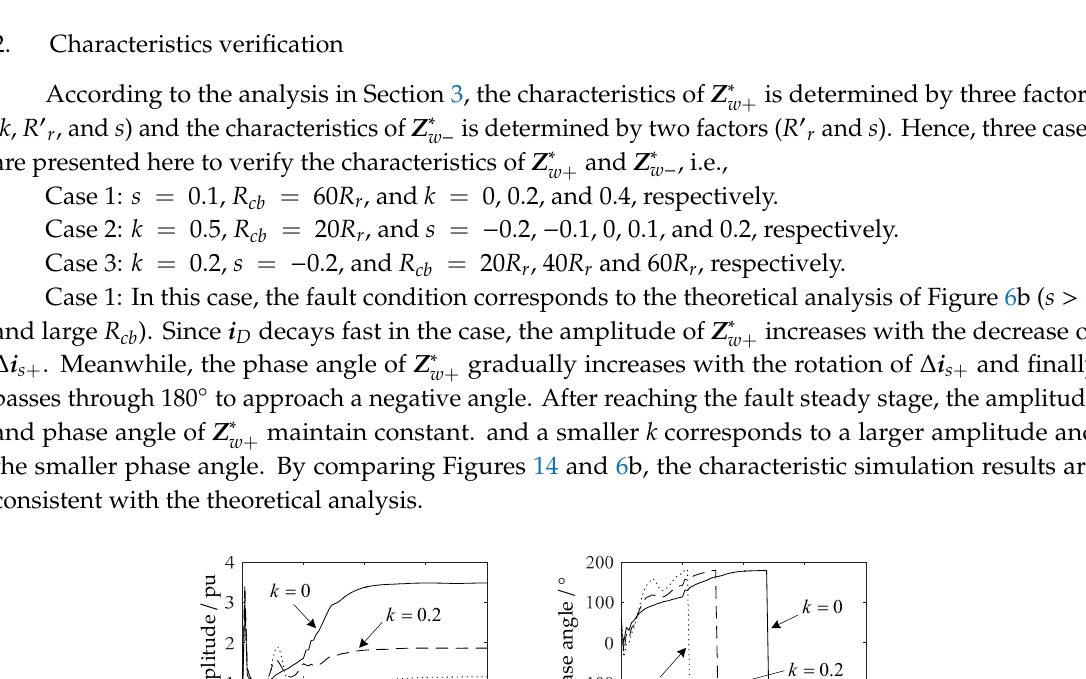
Figure 14. Characteristic simulation results of w